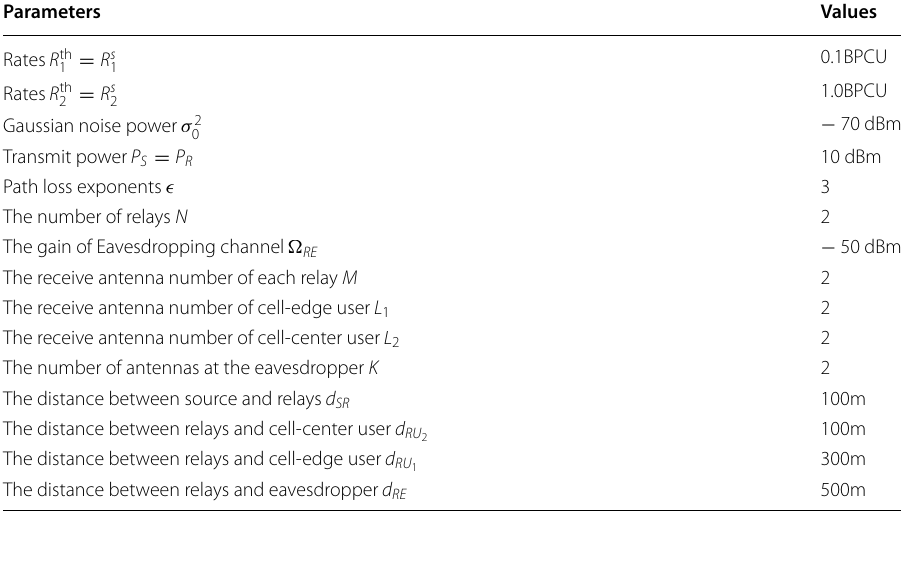
Table 1 Simulation Parameters Parameters